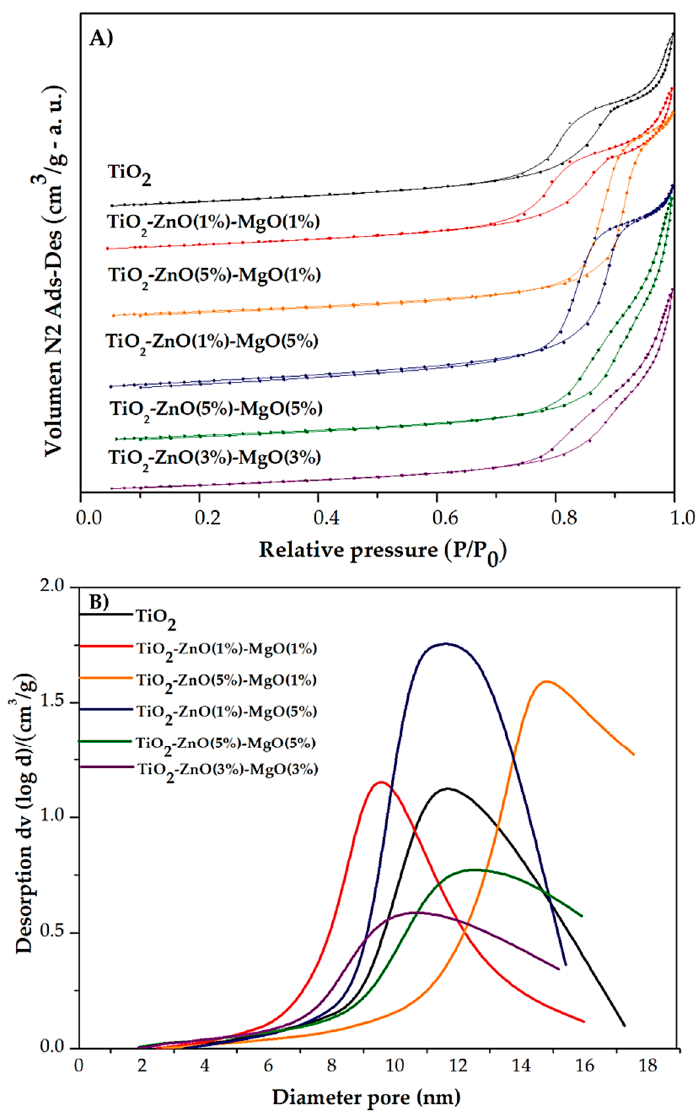
Figure 3. Nitrogen adsorption–desorption isotherms ( A ) and pore size distribution ( B ) of pure TiO 2 and mixed oxide nanomaterials.